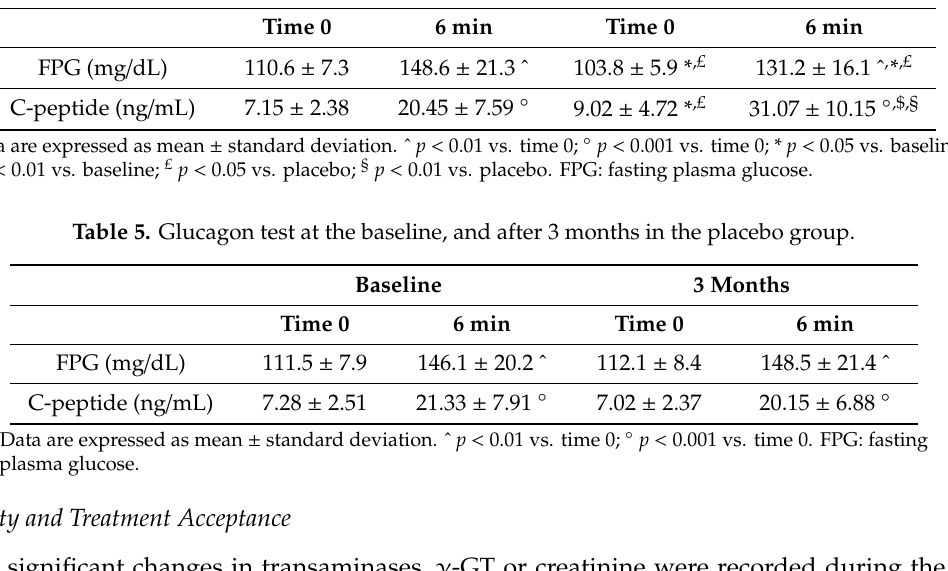
Table 4. Glucagon test at the baseline, and after 3 months in the abscisic acid (ABA) group. Baseline